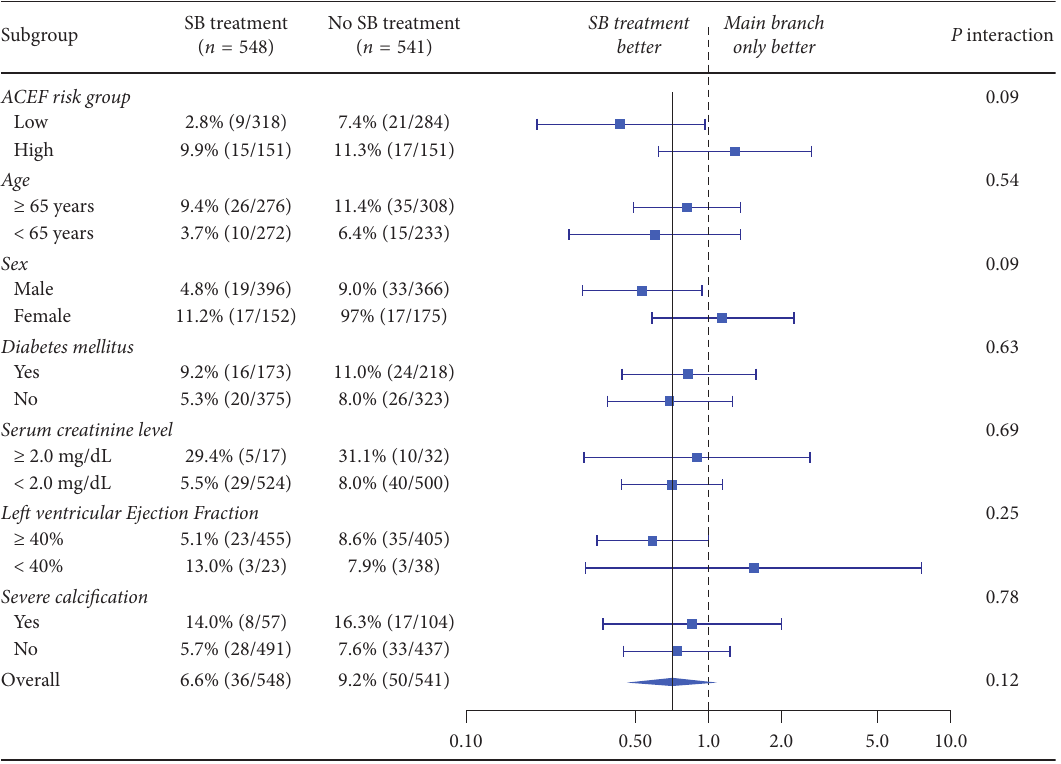
Figure 5: Subgroup analysis according to patient factors. SB, side branch; ACEF, age, creatinine, and ejection fraction score.